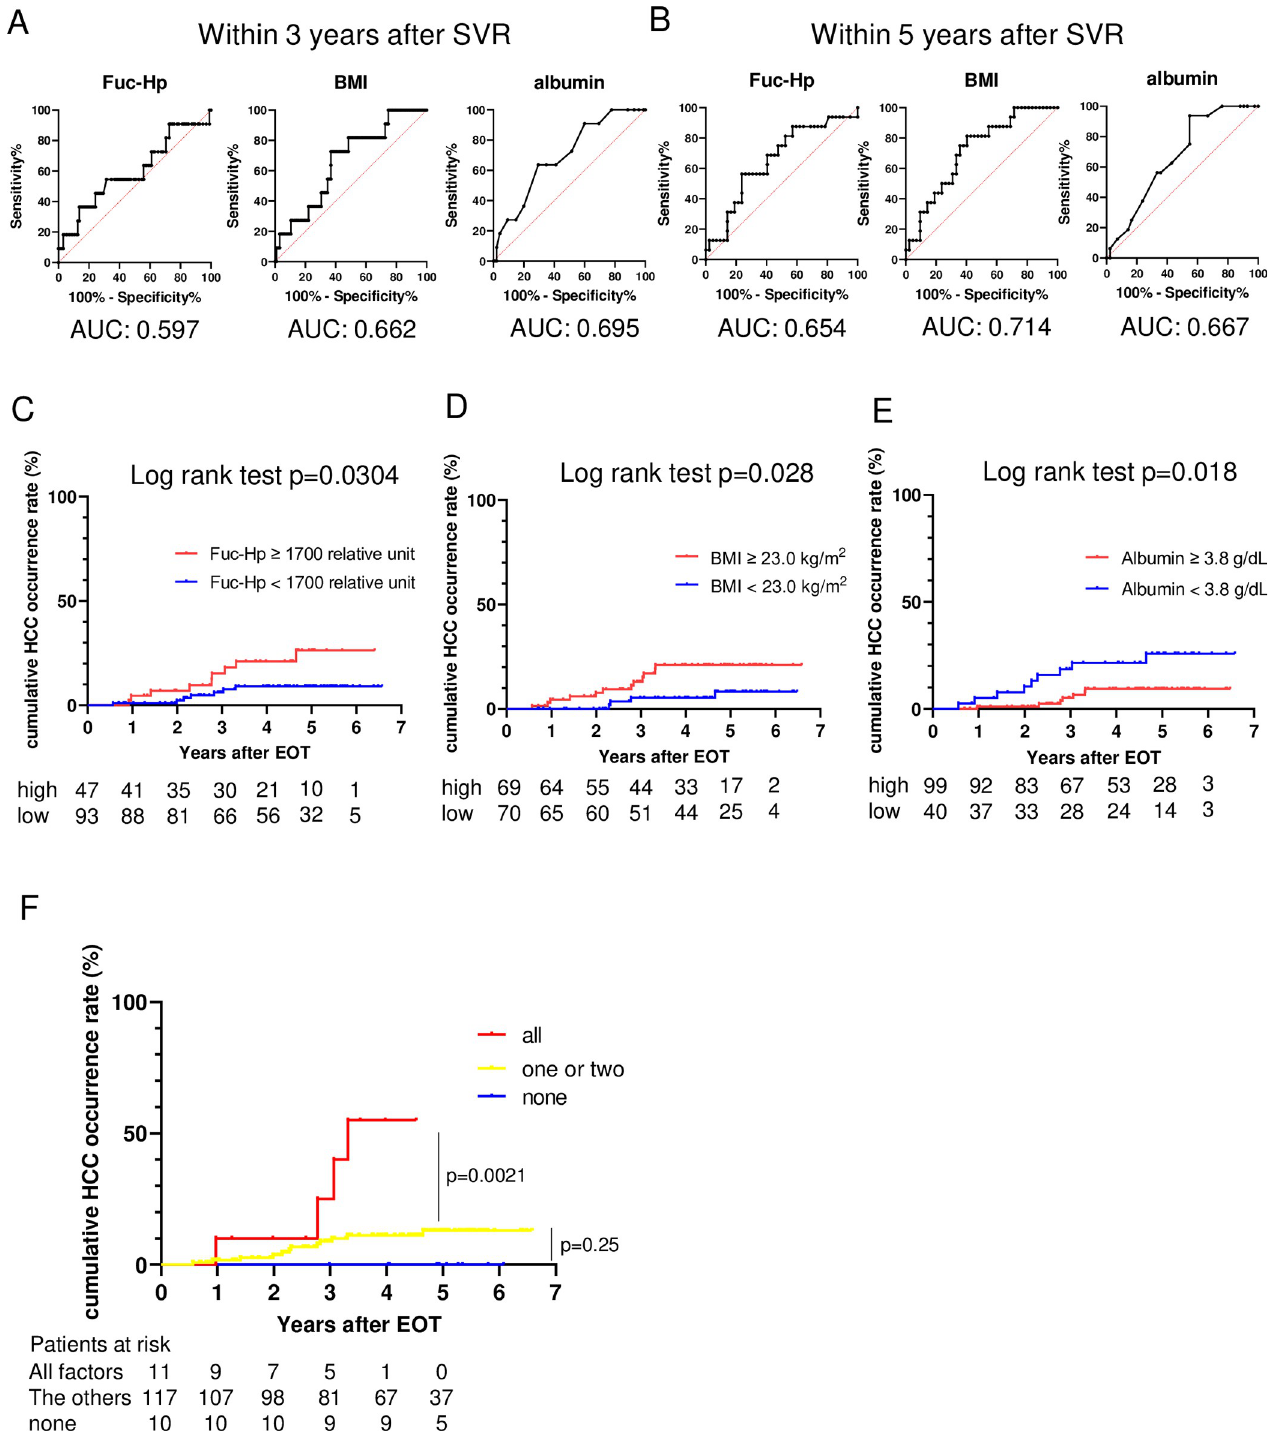
Fig 4. Serum fucosylated haptoglobin levels at EOT, BMI, and albumin levels at EOT stratify the risk of HCC occurrence after SVR. (A) ROC curves of Fuc-Hp, BMI, and albumin for predicting HCC occurrence within 3 years after SVR. (B) ROC curves of Fuc-Hp, BMI, and albumin for predicting HCC occurrence within 5 years after SVR. (C-E) Kaplan–Meier curves for HCC occurrence after SVR stratified according to a Fuc-Hp level of 1700 relative unit (C), BMI of 23 kg/m 2 (D), and albumin level of 3.8 g/dl (E). (F) Kaplan–Meier curves for HCC occurrence after SVR stratified into three groups according to the number of risk factors for HCC occurrence present: all, none, and one or two